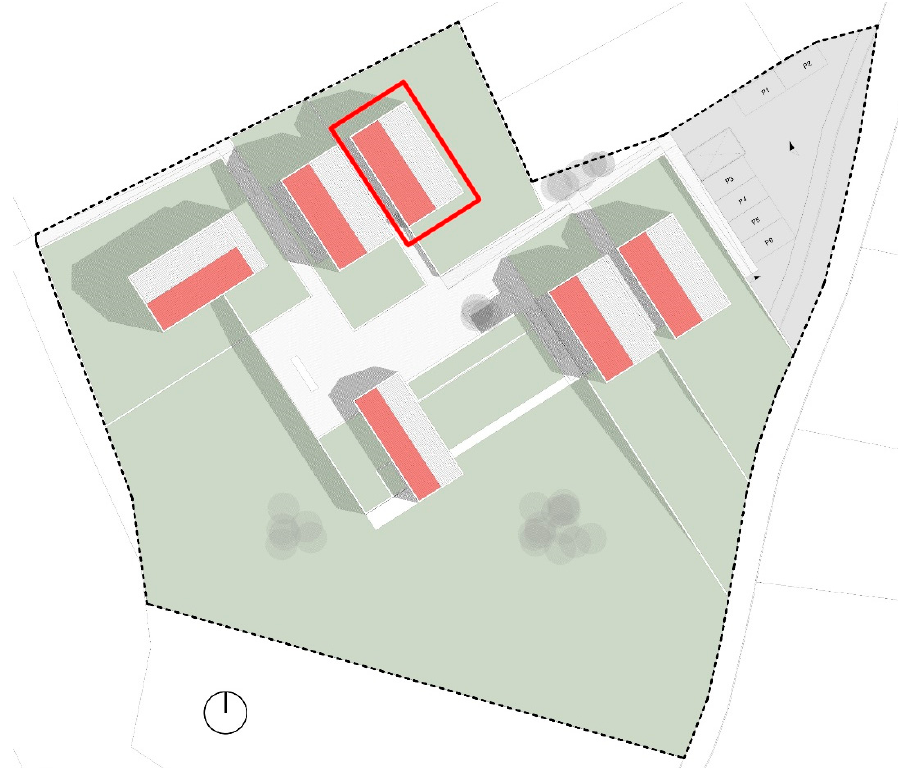
Figure 2. View of the site with an indication of the simulated house.